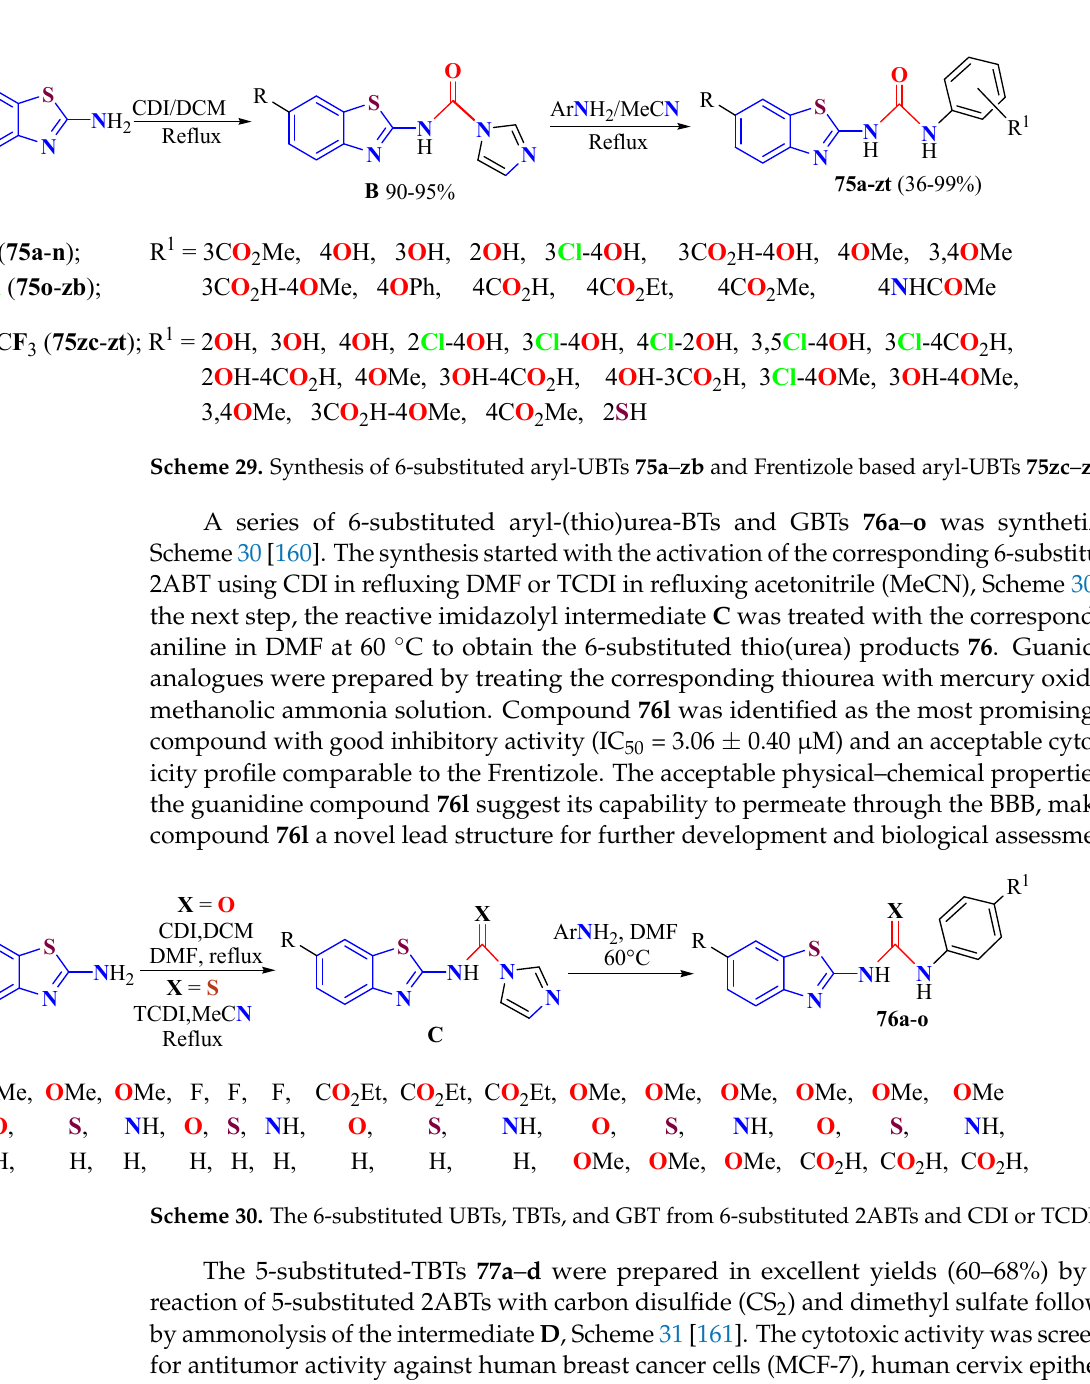
Reflux1. C S 2 , Na O H DMSO,